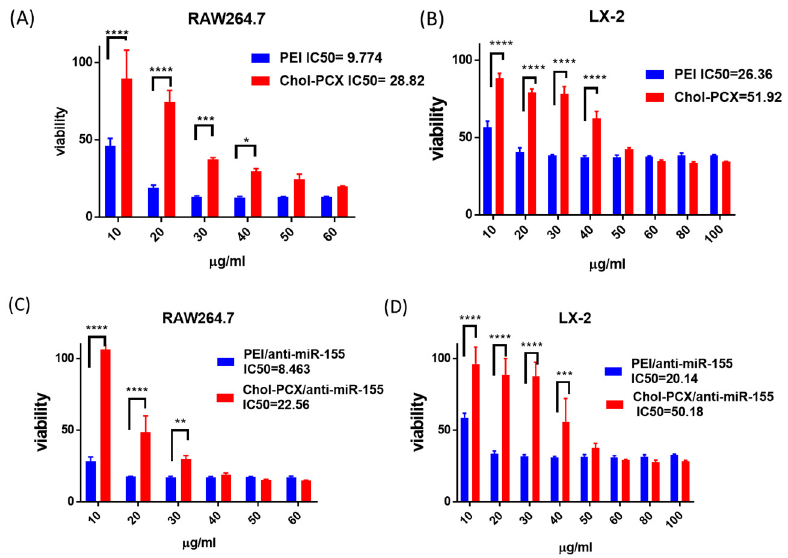
Figure 3. Cytotoxicity of Chol-PCX and Chol-PCX/anti-miR-155. ( A , B ) Cell viability of the polymers after 24 h of incubation with the macrophage RAW 264.7 and HSC LX-2. ( C , D ) Cell viability of Chol-PCX/anti-miR-155 after 24 h of incubation with the macrophage RAW 264.7 and HSC LX-2. Data were analyzed by one-way ANOVA followed by Tukey’s comparison test. Data are expressed with mean ± SD. * p < 0.05, ** p < 0.01, *** p < 0.001, and **** p < 0.0001.